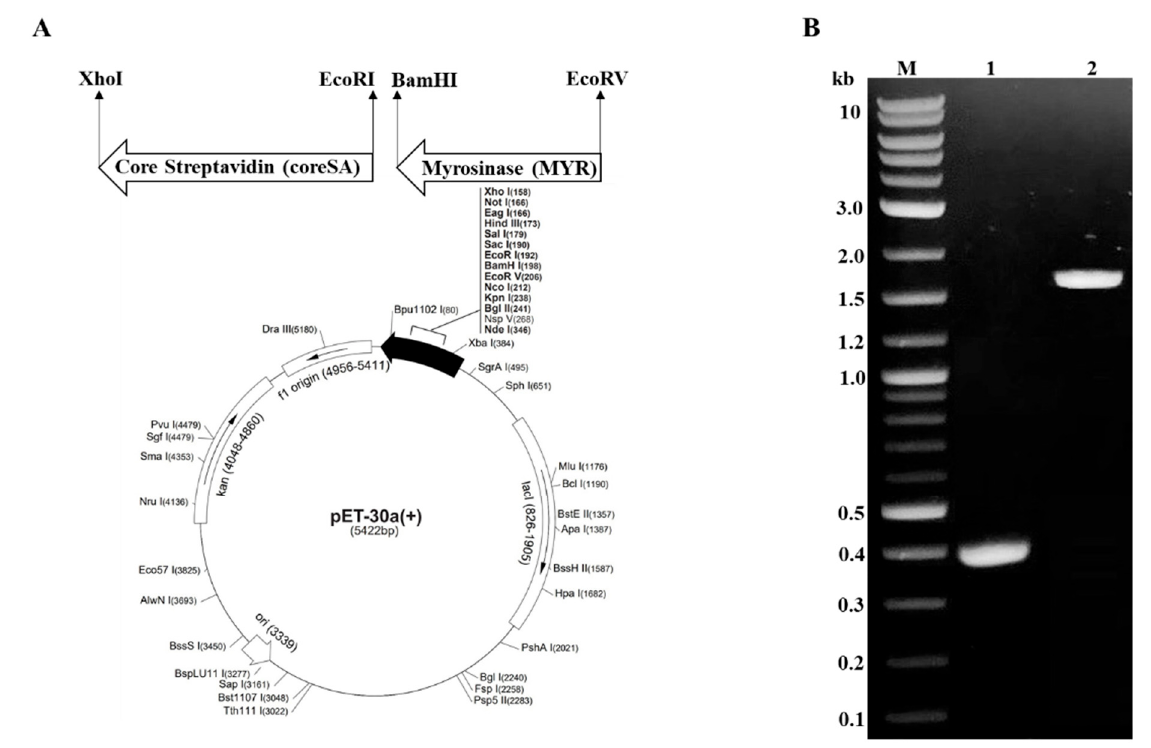
Figure 2. Construction of pMT002 vector. ( A ) Vector map shows the cloning site of MYR between EcoRV/BamHI and coreSA between EcoRI /XhoI, respectively. The direction of arrows shows the 5 ′ to 3 ′ end of each insert; ( B ) DNA agarose gel confirmation of PCR products (M: DNA ladder, Lane 1: coreSA, ~0.4 kb, Lane 2: MYR, ~1.6 kb) cloned from pMT002.